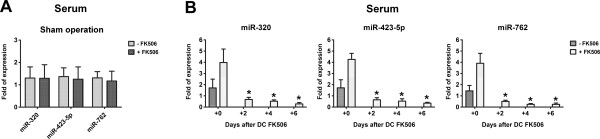
Quantification of the circulating miRNA targets by qRT-PCR in (A) the serum drawn from sham-operated mice at day 7 after nerve allotransplantation with or without daily FK506 injection and (B) at 2, 4, and 6 d after discontinuation of FK506 injection in the mice receiving nerve allotransplantation with FK506 immunosuppression for 7 d. Bars represent mean ± SEM values of 6 experiments; *P < 0.05.